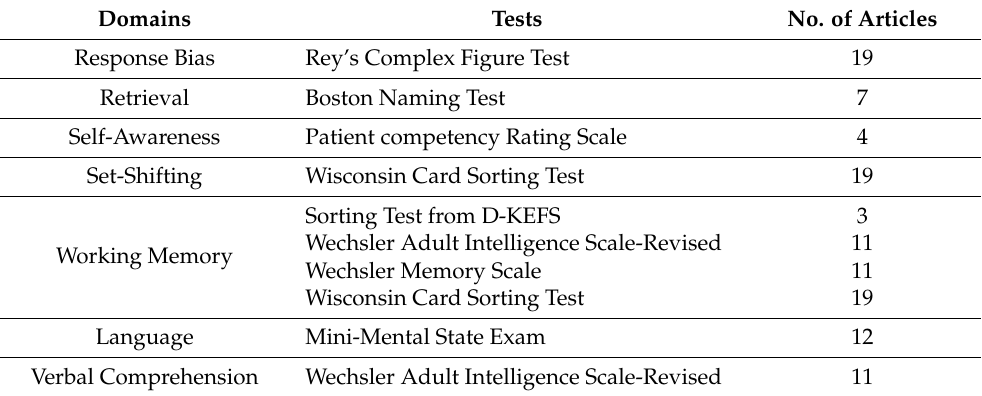
Table 4. Methods of administering and scoring assessments of cognition in coma survivors. Method of